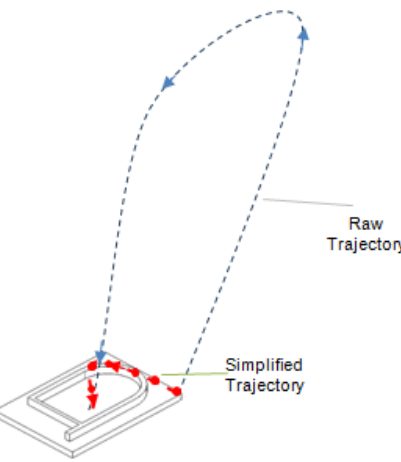
Figure 6. Raw trajectory after linear “shortcut optimization”.